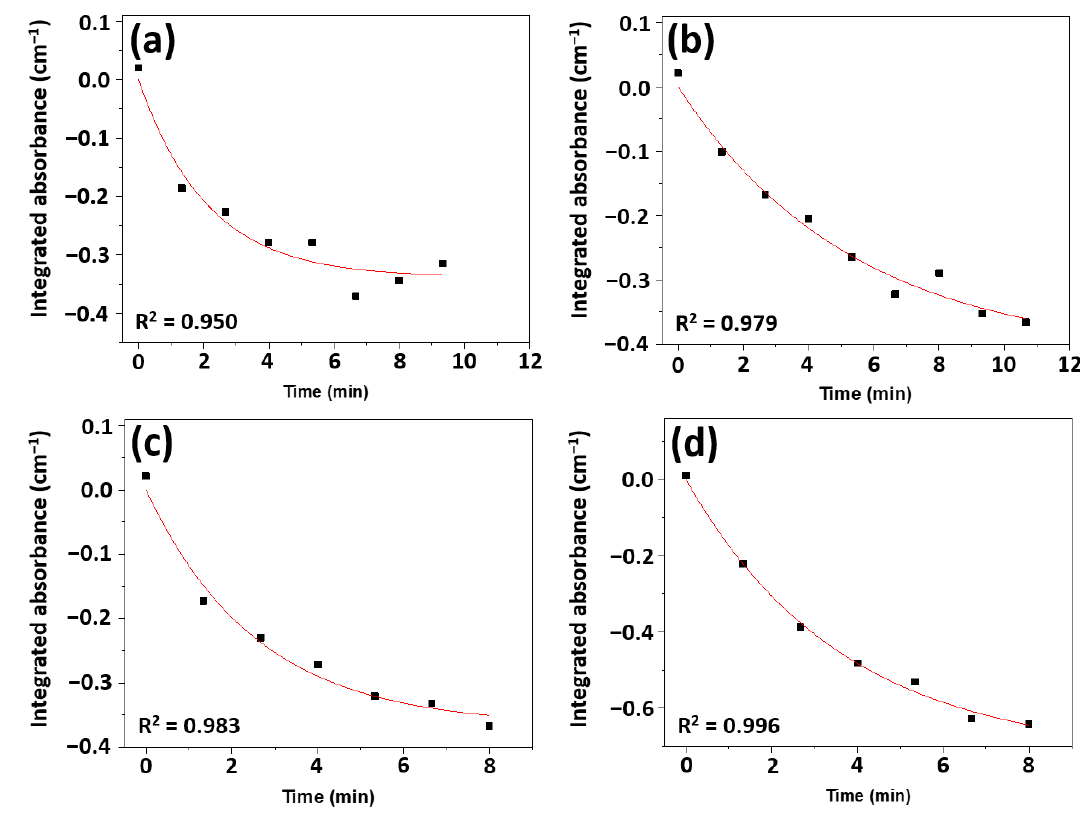
Figure 6. Integrated absorbance for the degradation of OPs during UV illumination for ( a )